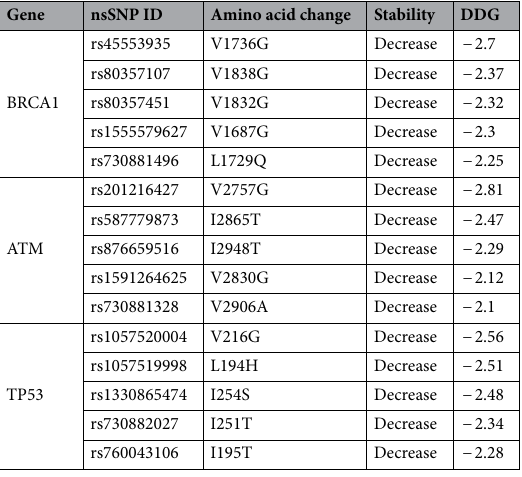
Table 2. I-MUTANT 2.0 predictions for nsSNPs with lower DDG values in BRCA1, ATM and TP53.